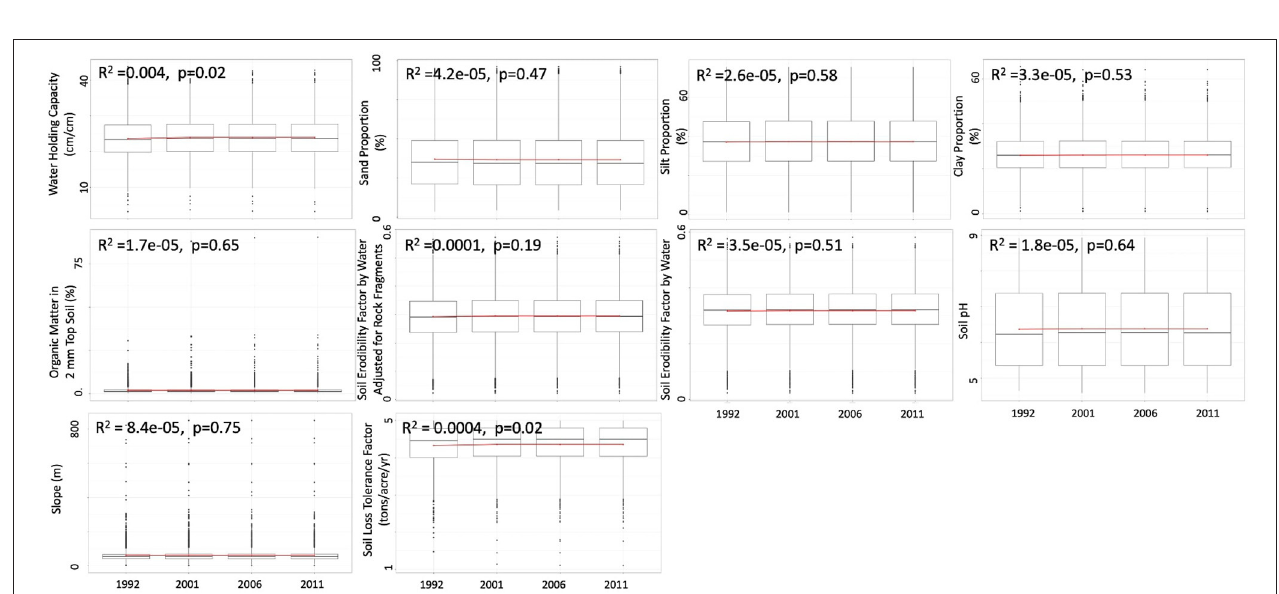
FIGURE 3 | Temporal trends of soil properties in the ACDC (Agro Climatic Data by County) dataset.